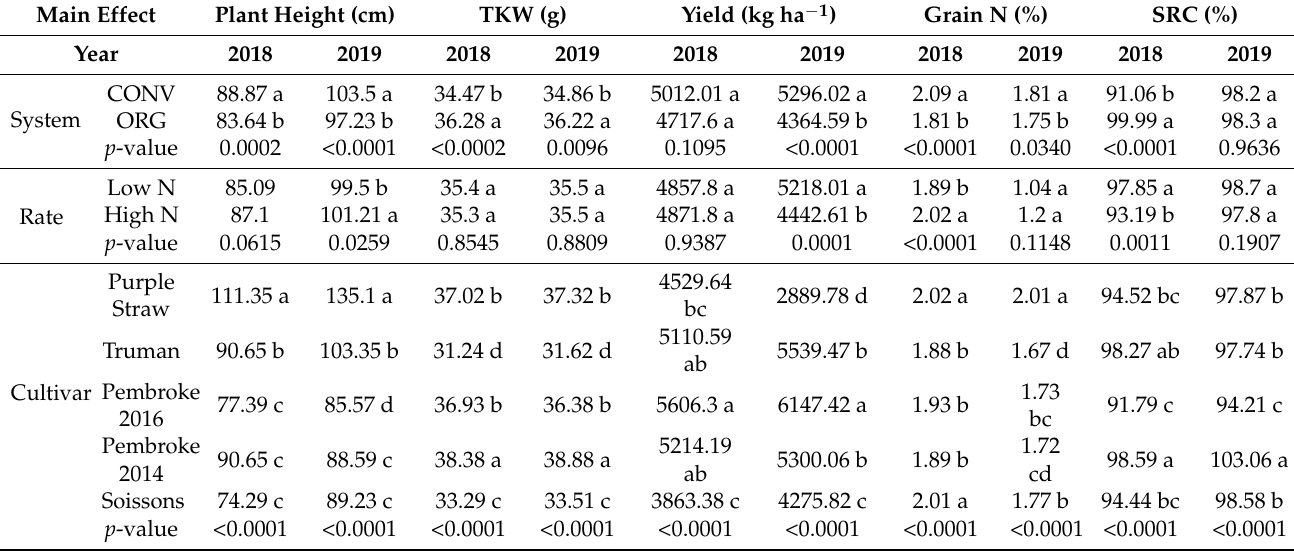
Table 1. Main effect for plant height (cm), 1000 kernel weight (TKW, g), yield (kg ha − 1 ), grain nitrogen (Grain N, %) and lactic acid (SRC, %). (Same letters within each column and main effect are not significantly different based on Tukey’s honest significant difference (HSD) test performed at α =